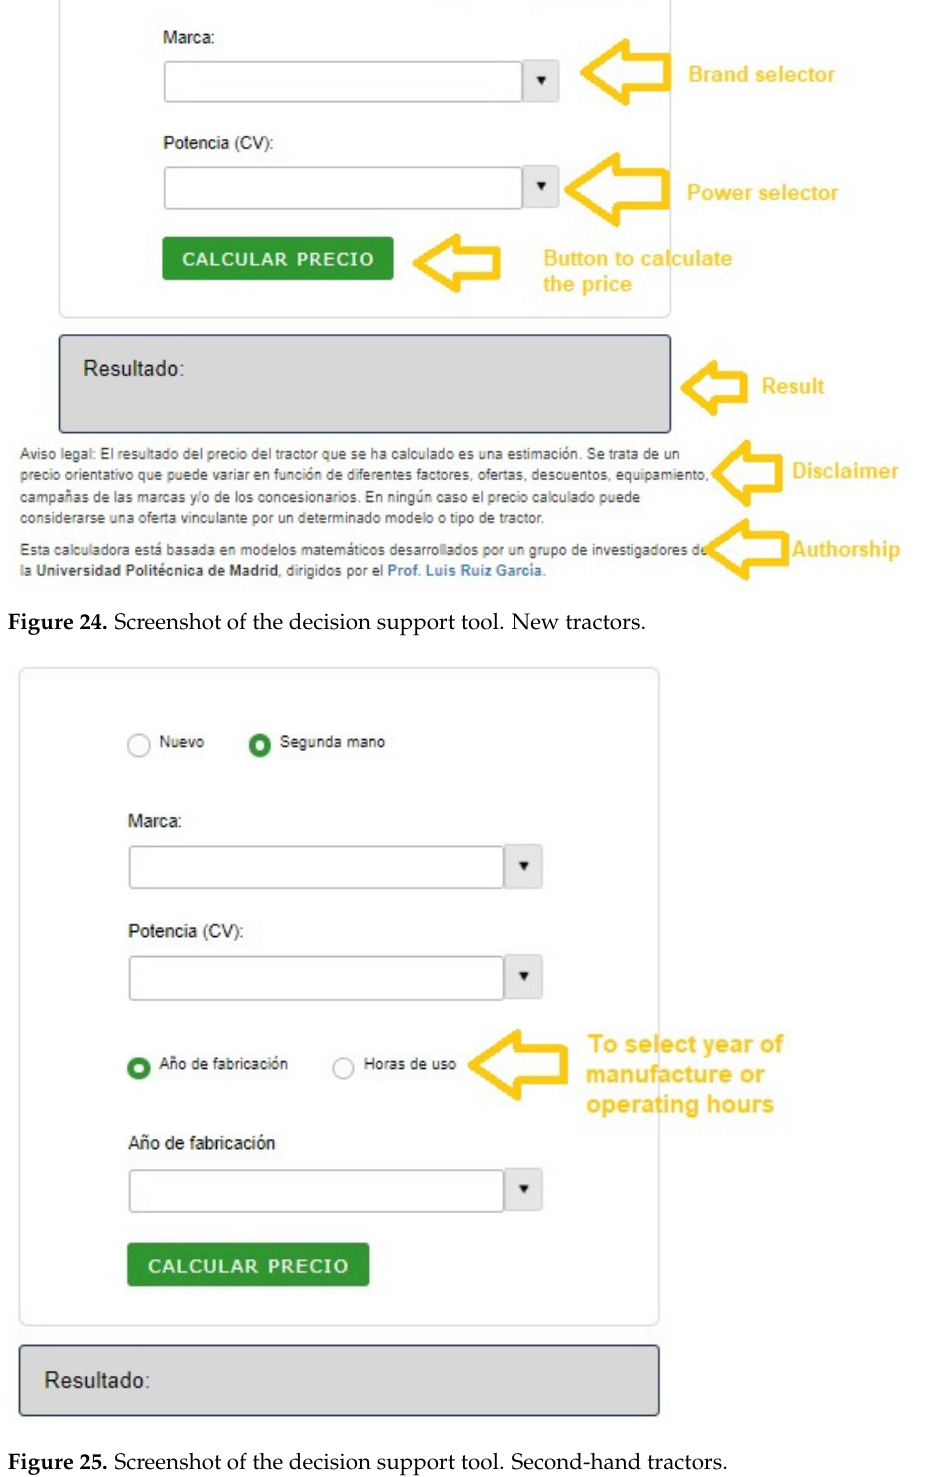
Figure 25. Screenshot of the decision support tool. Second-hand tractors.